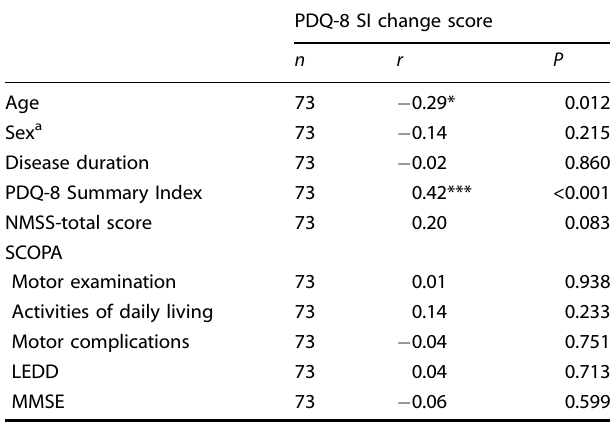
Table 2. Correlations between preoperative baseline test scores or demographic variables and 36-month change scores of quality of life.